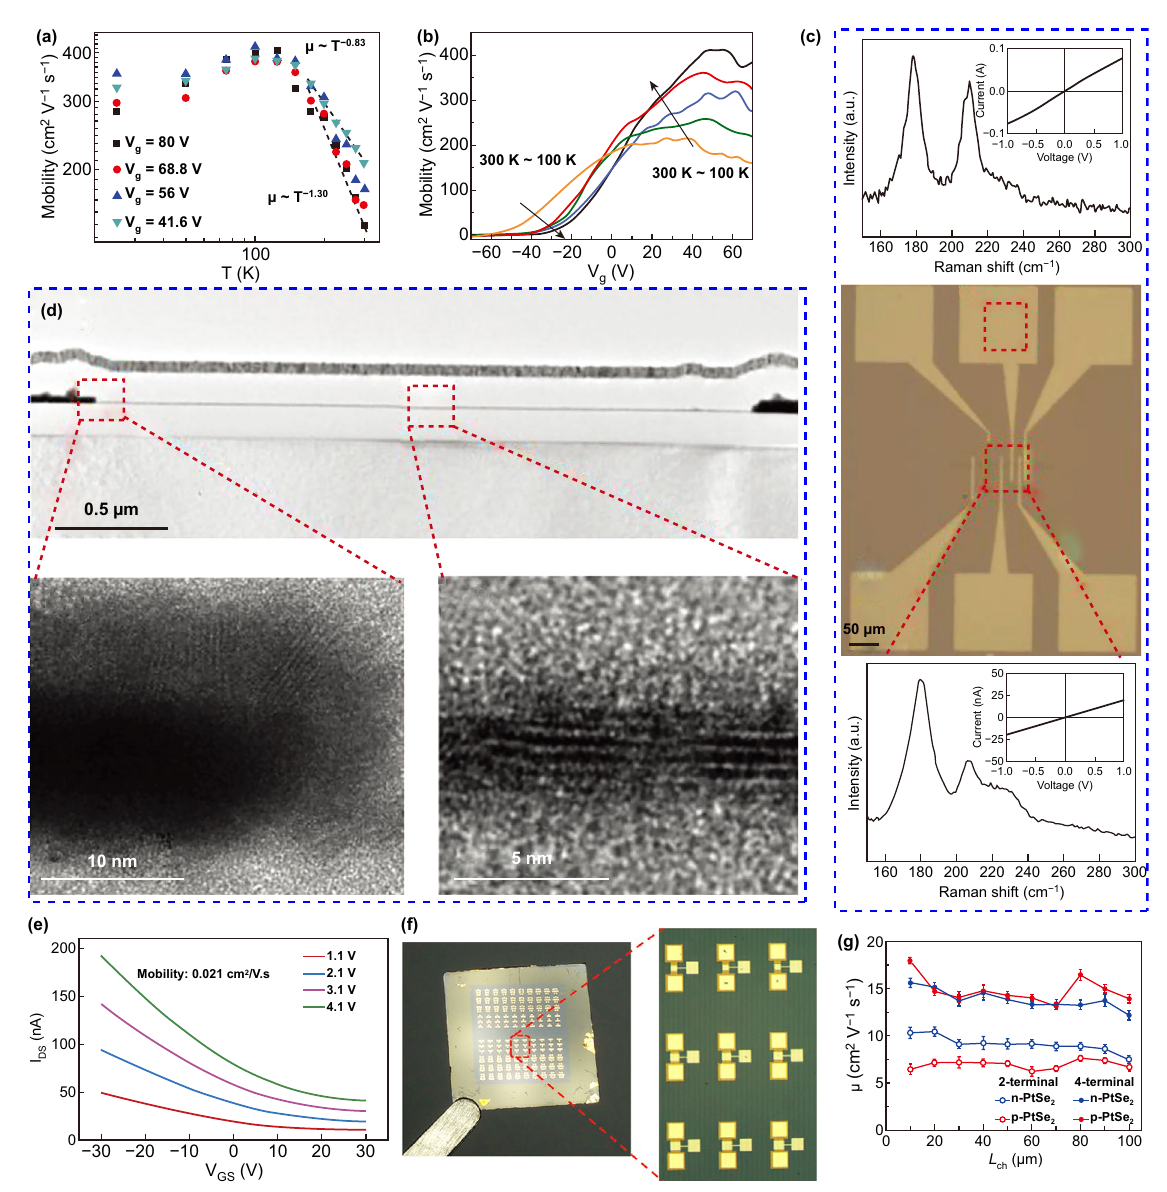
Fig. 12 Performance of 2D PtSe 2 FETs. a Temperature‑dependent field effect electron mobility of an 11‑nm‑thick PtSe 2 FET. b Field effect electron mobility versus gate voltage at different the temperature (from 100 to 300 K). Reproduced with permission [28]. Copyright 2018, John Wiley and Sons. c An optical microscope image of all PtSe 2 ‑based devices (middle) and the corresponding Raman spectra of the electrode (upper) and the channel (bottom) regions. d Cross‑sectional TEM images corresponding to the all PtSe 2 ‑based device shown in c . High magni‑ fication TEM images are an enlarge of the electrode (left) and channel (right) regions. e I D S – V G S curves at different V D S (which are set as 1.1, 2.1, 3.1, and 4.1 V). Reproduced with permission [55]. Copyright 2018, John Wiley and Sons. f Optical microscopic images of an PtSe 2 FETs array. g Comparison of the two terminals and four‑terminal mobility as a function of the channel length ( L ch ) for p ‑type and n ‑type PtSe 2 film‑ based devices. Reproduced with permission [107]. Copyright 2019, John Wiley and